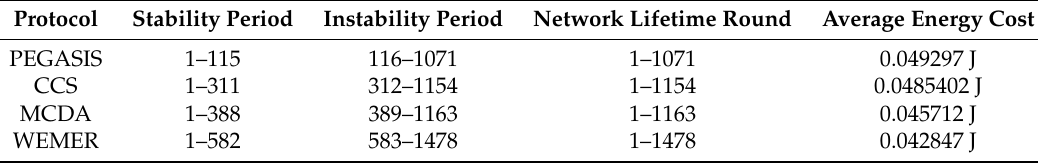
Figure 16. Number of dead nodes over round.